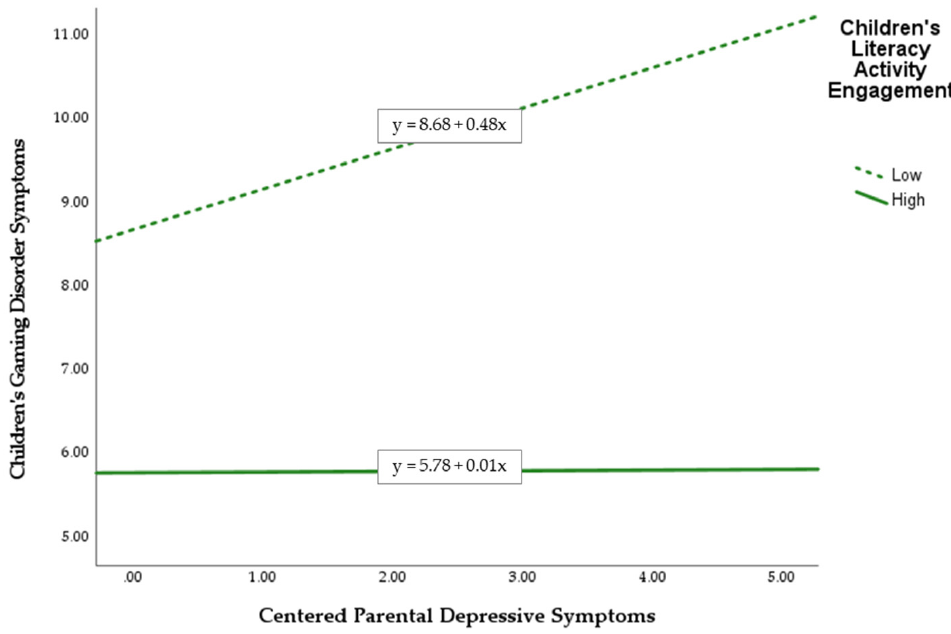
Figure 2. Plot of simple slope analysis for unpacking the significant interaction between parental depressive symptoms and children’s literacy activity engagement.